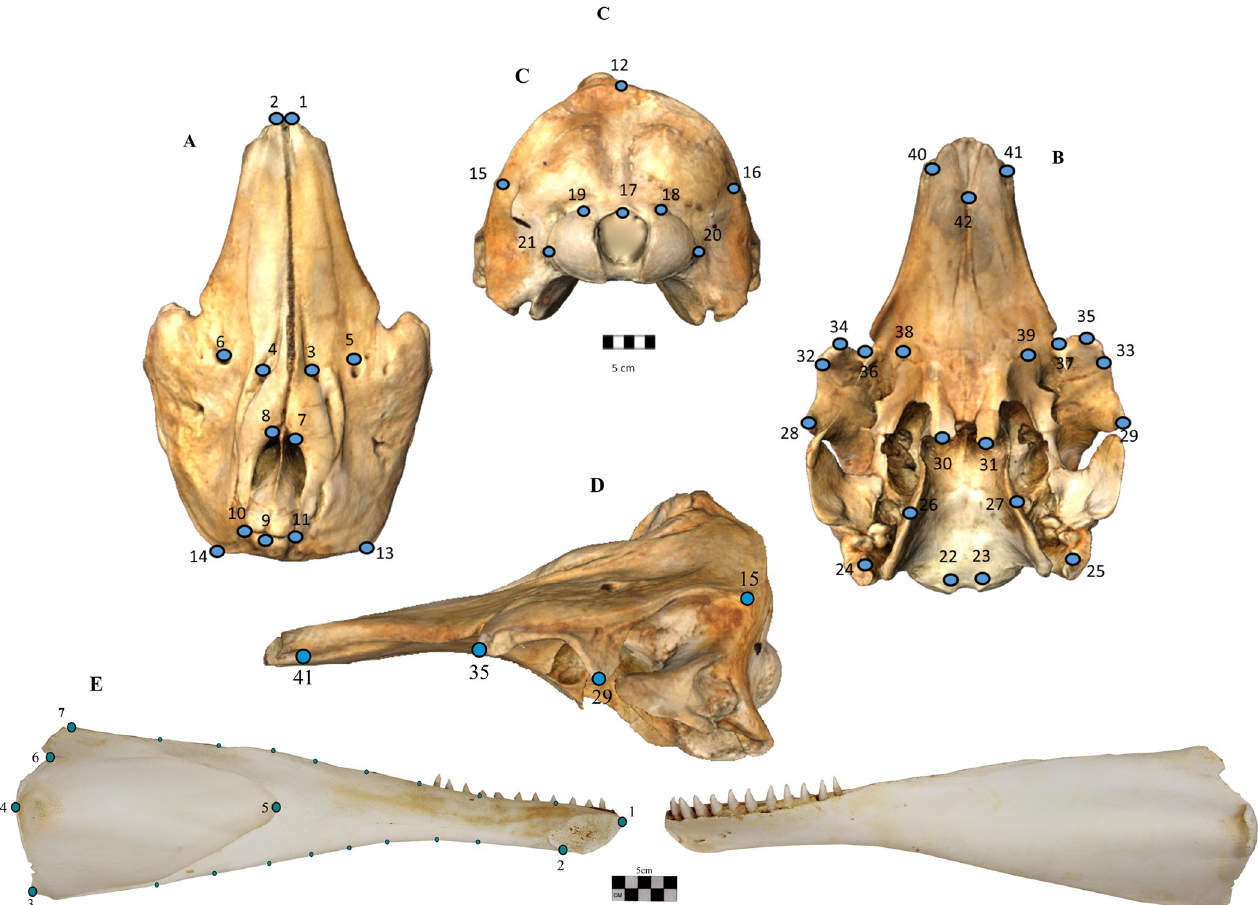
Fig 2. Landmark location in cranium and mandible. Landmark configuration on photogrammetric-based 3D model specimen for the cranium of a narwhal ( Monodon monoceros NHM 1937.10.30.2), in (A) dorsal, (B) ventral, (C) occipital and (D) left lateral view. (E) The position of the 7 anatomical landmarks, and 16 semilandmarks on a beluga left hemi-mandible ( Delphinapterus leucas NHMN 1098) in lingual view. The labial view of the hemi-mandible is also provided. Scale bar 5 cm.